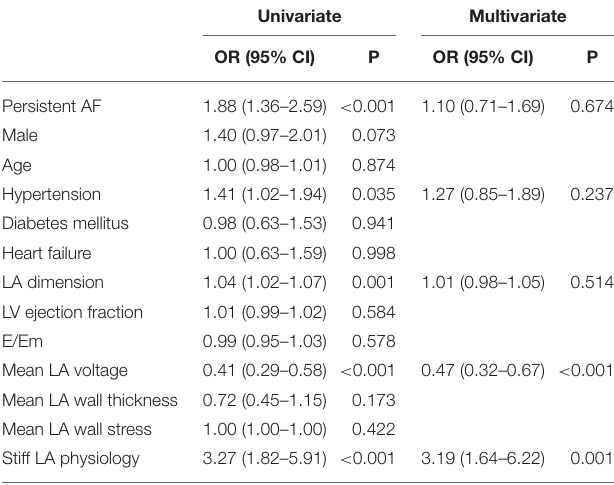
TABLE 4 | Logistic regression analysis for failed rhythm control within 1 year.